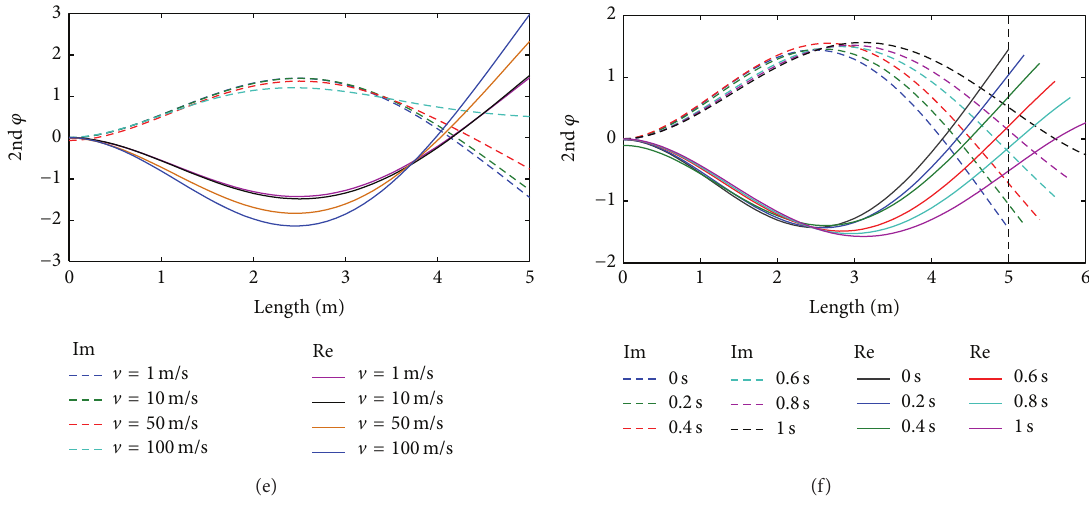
Figure 2: (a) Natural frequency changes with velocity. (b) Natural frequency changes with time. (c) V = 10 m/s, the modal function changes. (d) V = 10 m/s, the tip displacement changes. (e) 𝑚 = 5 kg, the modal function changes with velocity. (f) 𝑚 = 5 kg, V = 1 m/s, the modal function changes with different length.